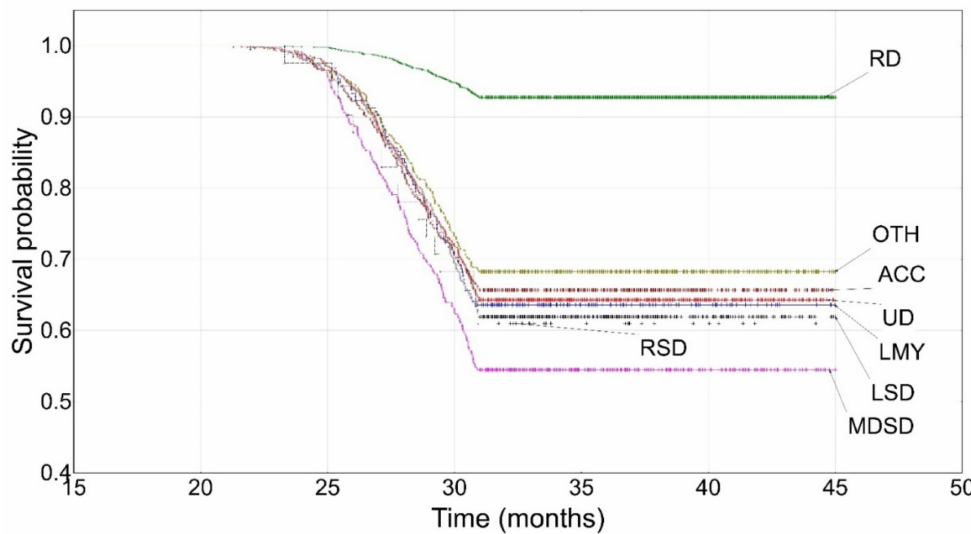
Figure 1. The Kaplan–Meier survival probability until the first lactation. UD—udder diseases, RD—reproductive disorders, MDSD—metabolic and digestive system diseases, RSD—respiratory system diseases, LSD—locomotor system diseases, ACC—accidents, OTH—others, LMY—low milk